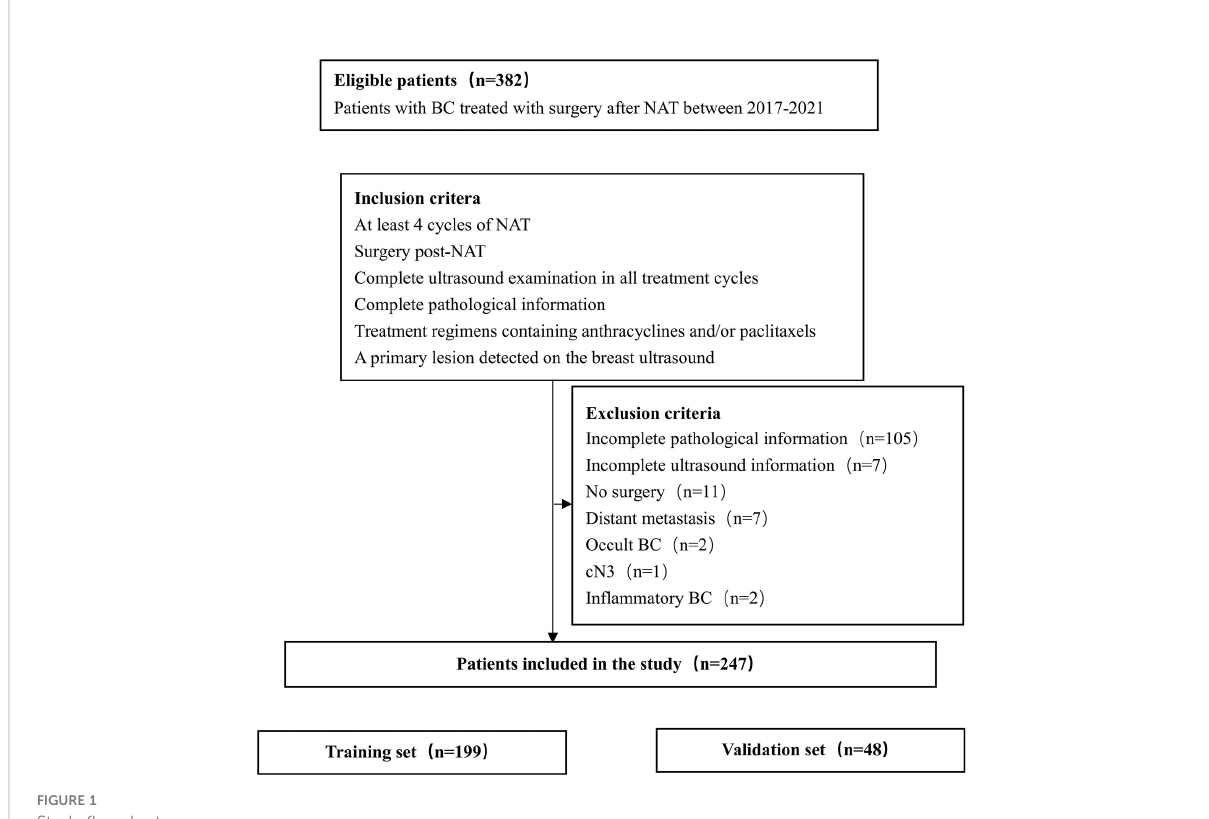
FIGURE 1 Study fl